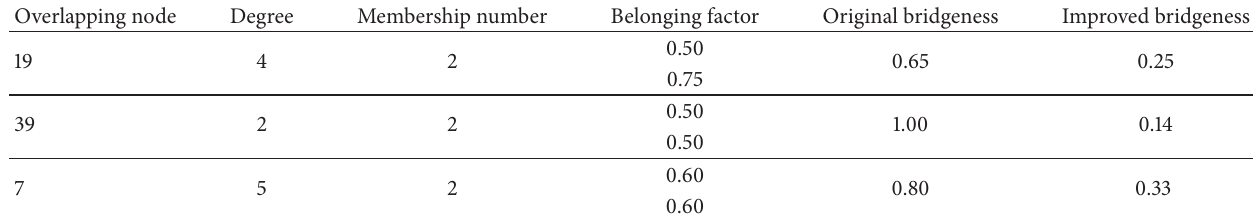
Table 4: The detailed information of overlapping nodes in Dolphins interaction network.